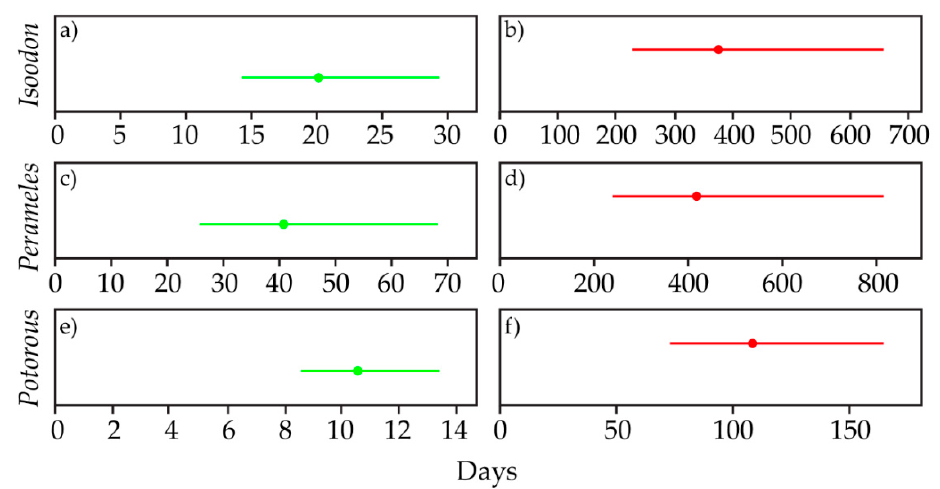
Figure 9. Number of days required to be 95% certain that non-detection of a target species ( Isoodon , Perameles and Potorous ) could be interpreted as its absence. Calculations are based on best case ( a , c , and e ; green; i.e., a favourable environment) and worst case ( b , d , and f ; red; i.e., an unfavorable detection environment) scenarios of the respective target species. Central mark represents the predicted estimate and bars represent the 95% confidence interval.